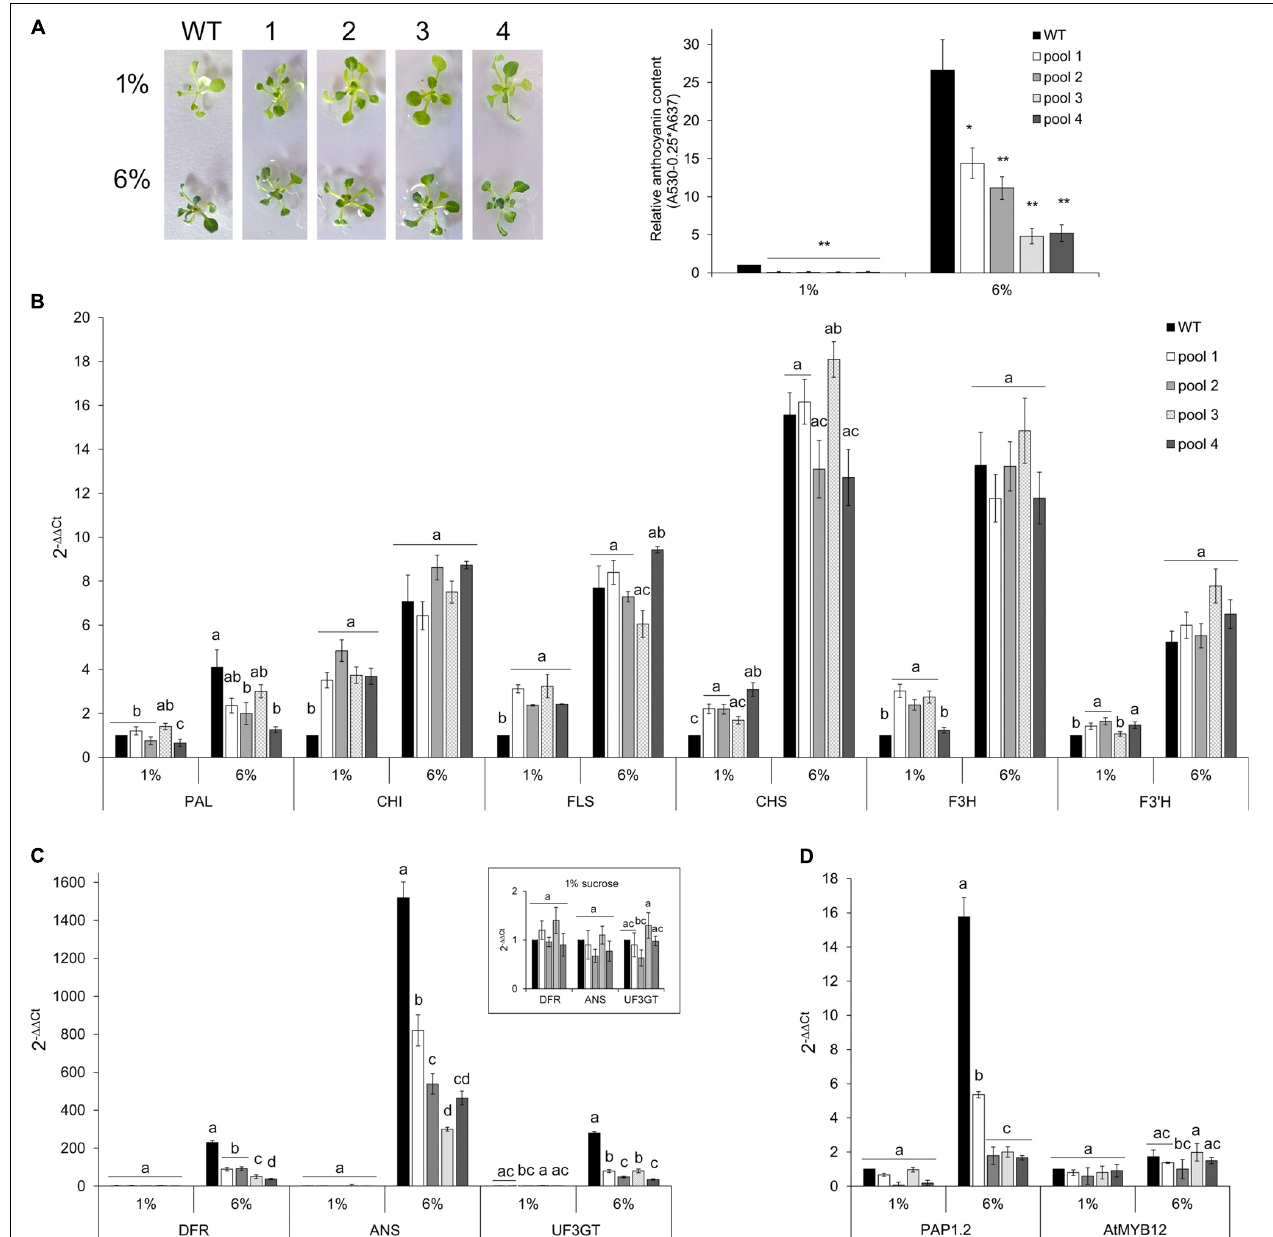
FIGURE 6 | Anthocyanin content and qRT-PCR analysis in Arabidopsis seedlings grown on control and anthocyanin inductive medium. (A) Left panel: 20-days-old Arabidopsis wild type (WT) and CcMYB12 seedlings (1, 2, 3, and 4) grown in MS medium supplemented with 1 or 6% sucrose under long day condition. Right panel: Anthocyanin content in 2-weeks-old WT and CcMYB12 seedlings grown in 1 and 6% sucrose. Values are reported as relative to WT 1% sucrose, set as 1. Data represent mean values (+SD, n = 3). Within each growth condition, asterisks ∗ and ∗∗ indicate statistically significant differences ( P < 0.05 and P < 0.01 respectively), between the means for WT and tested transgenic samples according to Student’s t -test. (B–D) qRT-PCR analysis of early (B) and late (C) flavonoid biosynthetic genes, and AtPAP1 and AtMYB12 TFs (D ) in seedlings grown in 1 and 6% sucrose. Upper panel in (C) represents late biosynthetic genes with a low expression level in 1% sucrose condition, with the appropriate axis scale. Actin was employed as reference gene. WT grown in 1% sucrose is the calibrator. Values are means ± SD of three biological replicates. Bars with different letters are statistically different to each other according to one-way ANOVA Tukey test ( p <